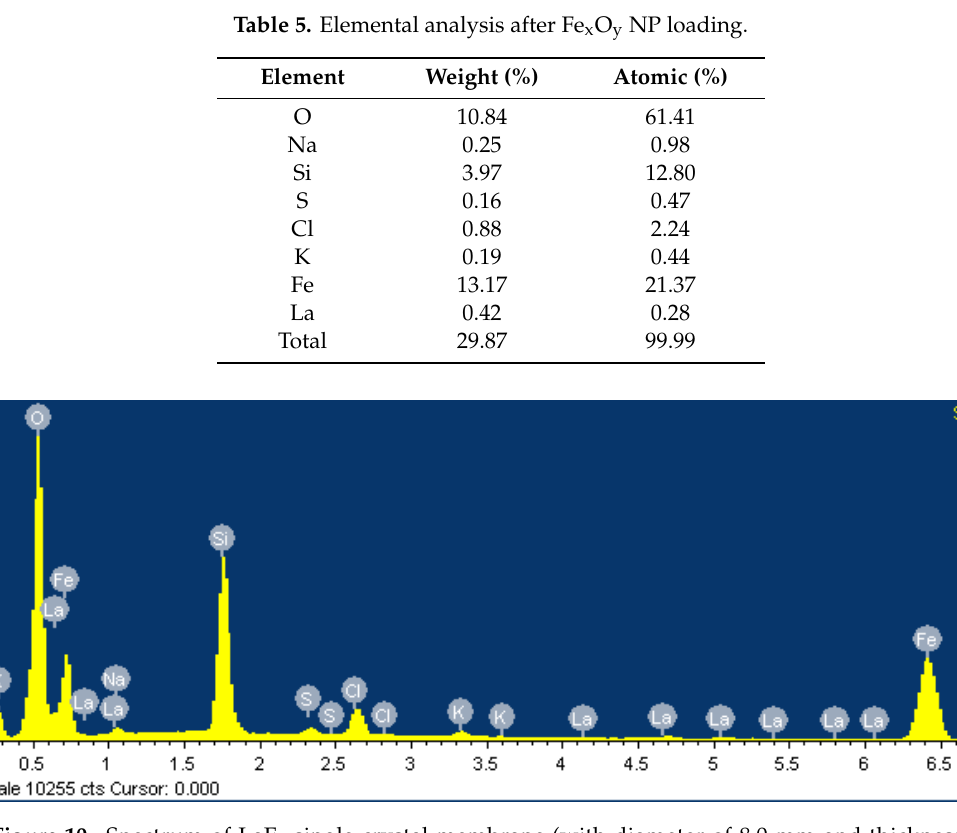
Figure 10. Spectrum of LaF 3 single-crystal membrane (with diameter of 8.0 mm and thickness of 1.0 mm, doped with 1.0% Eu) after Fe x O y NP loading.